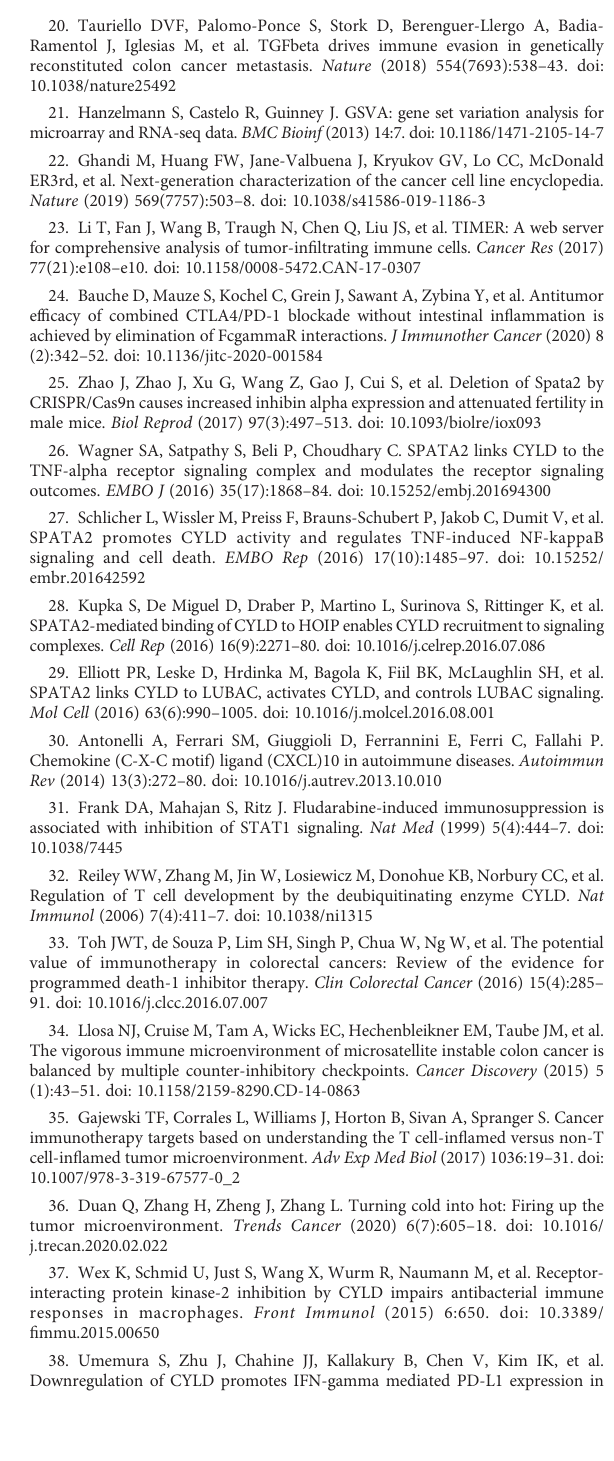
gMDSCs(bottomleftgraph)andmMDSCs(bottomrightgraph)pergramof tumorswasassessedby fl owcytometryatday8posttreatment.Resultsare Correlation coef fi cients and p values of all genes with CXCL9/10/11 and GEP scores in TCGA. Expression levels in CCLE CRC cell lines and genes selected for downstream validation are also